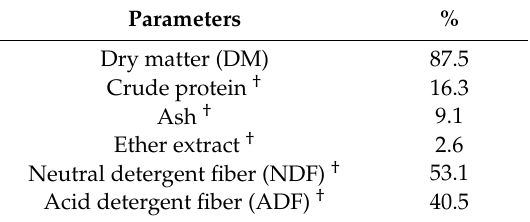
Table 1. Chemical composition of alfalfa hay administered to all animals involved in the